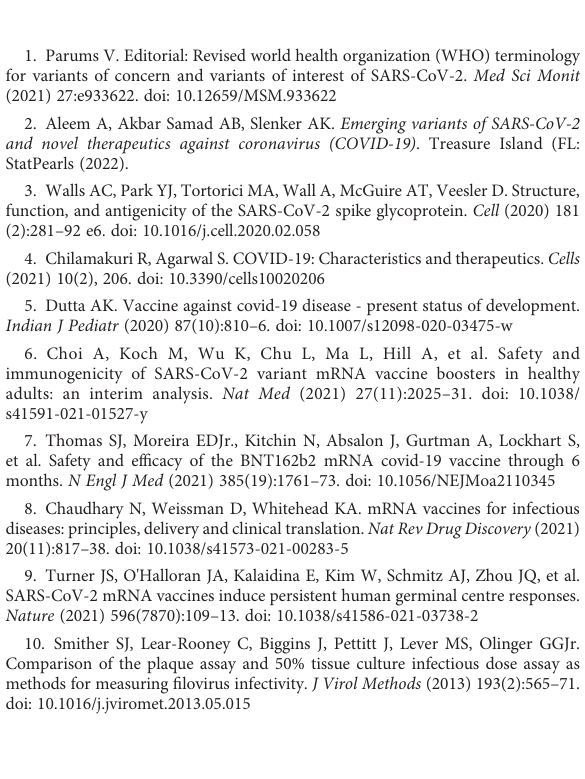
SUPPLEMENTARY FIGURE 3 Gating strategy for analysis of IL21 + Tfh cells. The peripheral blood mononuclear cells collected from immunized NHPs shown in were stained with L/D FVS700, CD3 APC-Cy7, CD8 BV480, CD45RA PE-Cy5, CCR7 BV421, CXCR5 PE, PD-1 BV785, ICOS PE-Cy7and IL21 APC, and tested for the rates of IL21 + Tfh cells via FACS. Tfh cells were gated as singlets, living, CD3 + , CD8 - , CCR7 + , CD45RA - , CXCR5 + , PD-1 + and ICOS + lymphocytes. One case immunized with 30 m g SYS6006 was presented as a gatingexample. NHPs,non-human primates; Tfh,Tfollicular helper cell; PMA, phorbol 12-myristate 13-acetate. SUPPLEMENTARY FIGURE 4 GatingstrategiesforanalysisofIFN g + andIL2 + Th1 cellsandIL4 + andIL13 + Th2 cells. The peripheral blood mononuclear cells collected from immunized NHPs were stained with L/D FVS660, CD3 APC-Cy7, CD8 BV480, CD4 PerCP, IL2 BV750, IFN g Alexa Fluro700 , IL4 FITC and IL13 BV421, and tested for the rates of Th1 and Th2 cells via FACS. One case immunized with 30 m g SYS6006 was presented as a gating example. SUPPLEMENTARY FIGURE 5 The antigen-speci fi c Th1 cells in NHPs immunized with two different doses of SYS6006. Cynomolgus macaques were intramuscularly immunized with the indicated doses of SYS6006 and boosted with a 21- day interval using the same dose. The peripheral blood mononuclear cells were collected from NHPs 50 days after the 1 st vaccination, stimulated with a peptide pool of SARS-CoV-2 S protein, and tested for the rates of IL2 + (A) and IFN g + (B) Th1 cells via FACS analysis (n=2). Data are presented as mean ± SD. PMA/Ionomycin was positive control to stimulate T cells. NHPs, non-human primates; PMA, phorbol 12-myristate